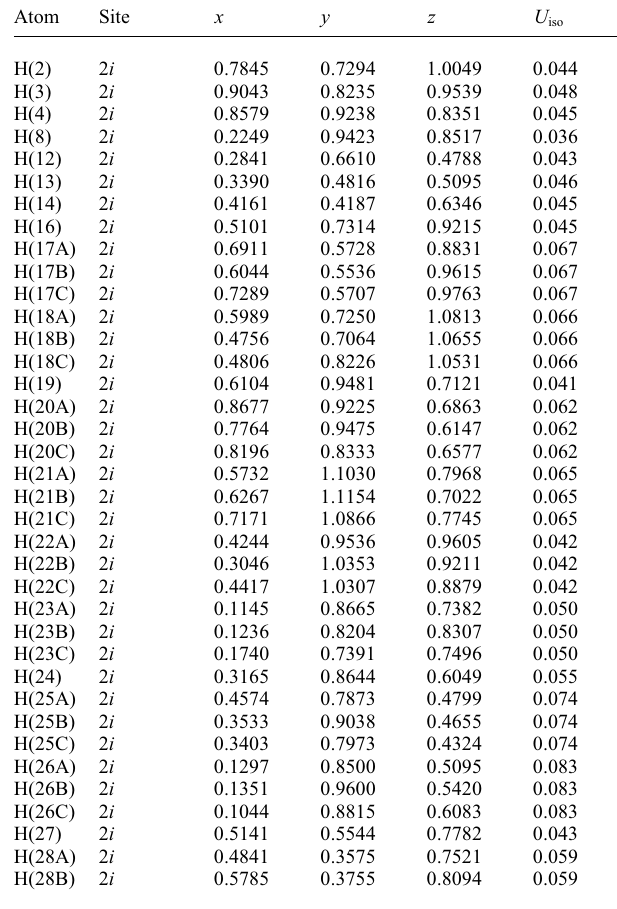
Table 2. Atomic coordinates and displacement parameters (in Å 2 )